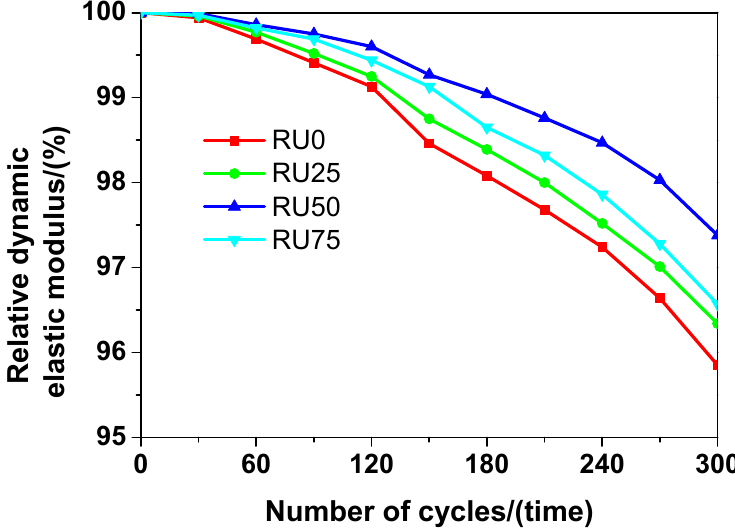
ff erent contents of